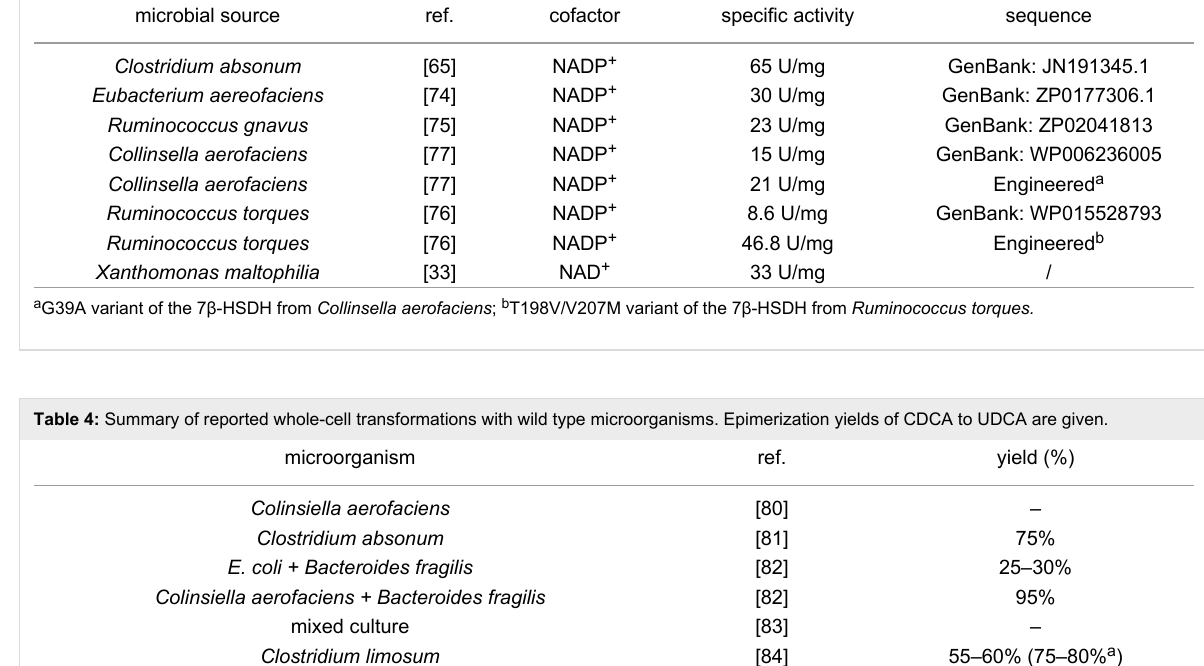
Table 3: Summary of reported 7 β -HSDH. The given activity is based on 7-oxo-LCA as substrate. microbial source ref.